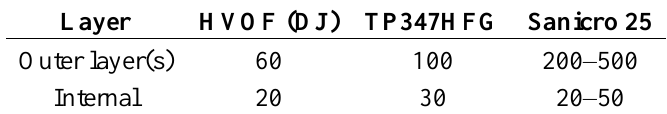
Table 5. Corrosion layer thicknesses in μm at 650 °C. HIP sample was not exposed at this temperature. The HVOF coating was exposed for 700 h while the others were exposed for 1000 h.